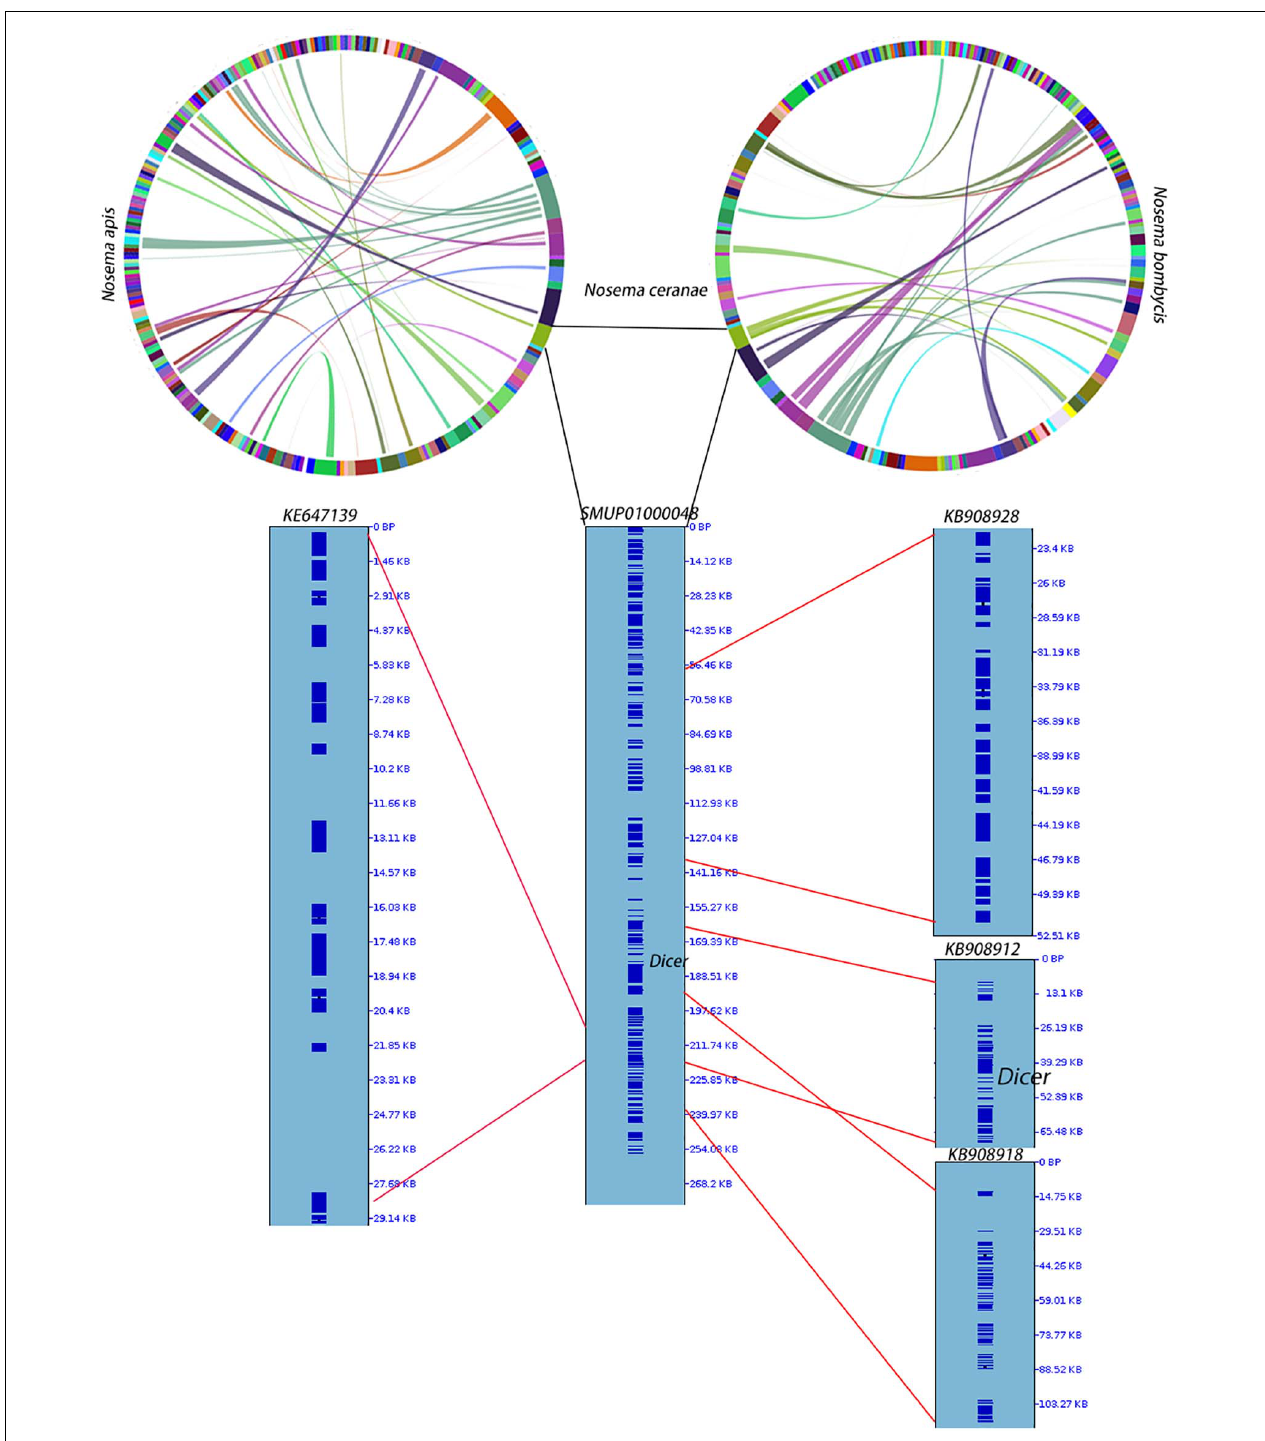
FIGURE 3 | Synteny among N. apis , N. ceranae and N. bombycis . At the genome level, 28 synteny blocks were identified between N. bombycis and N. ceranae . Additionally, 34 synteny blocks were identified between N. apis and N. ceranae . Surprisingly, a synteny block with the gene Dicer is not shared among the three species. The gene Dicer was predicted in N. ceranae contig (SMUP01000048). The paired synteny block between N. ceranae and N. apis , as well as between N. ceranae and N. bombycis were further shown in this contig. The corresponding region are shown on the right of the contig and the region with red lines indicates a synteny block. A synteny block with the gene Dicer was identified between N. ceranae and N. bombycis .